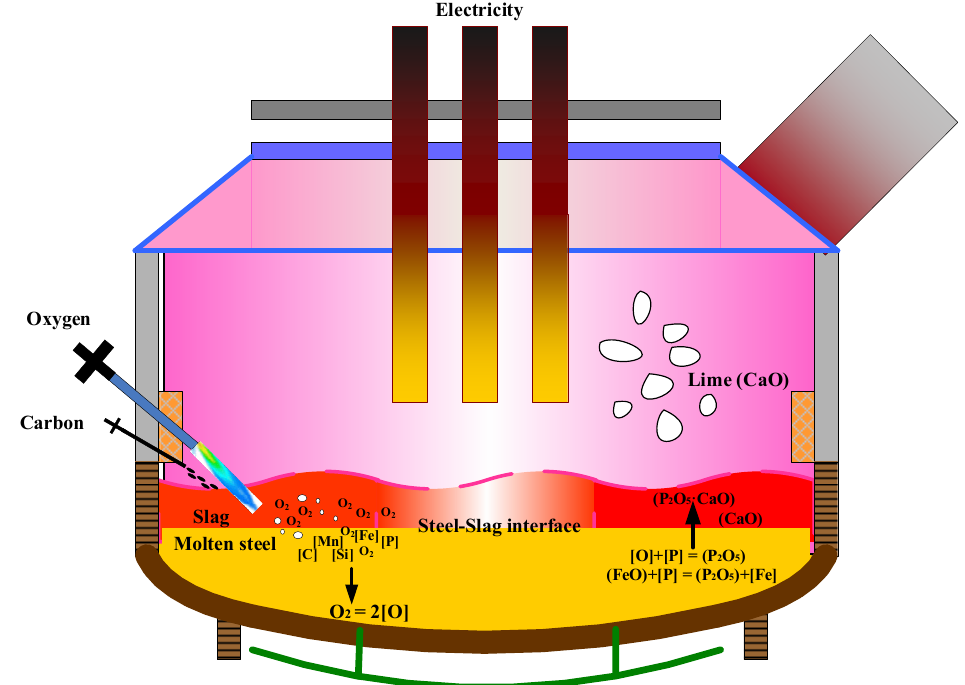
Figure 2. Thermodynamic reactions in electric arc furnace (EAF) steelmaking process.